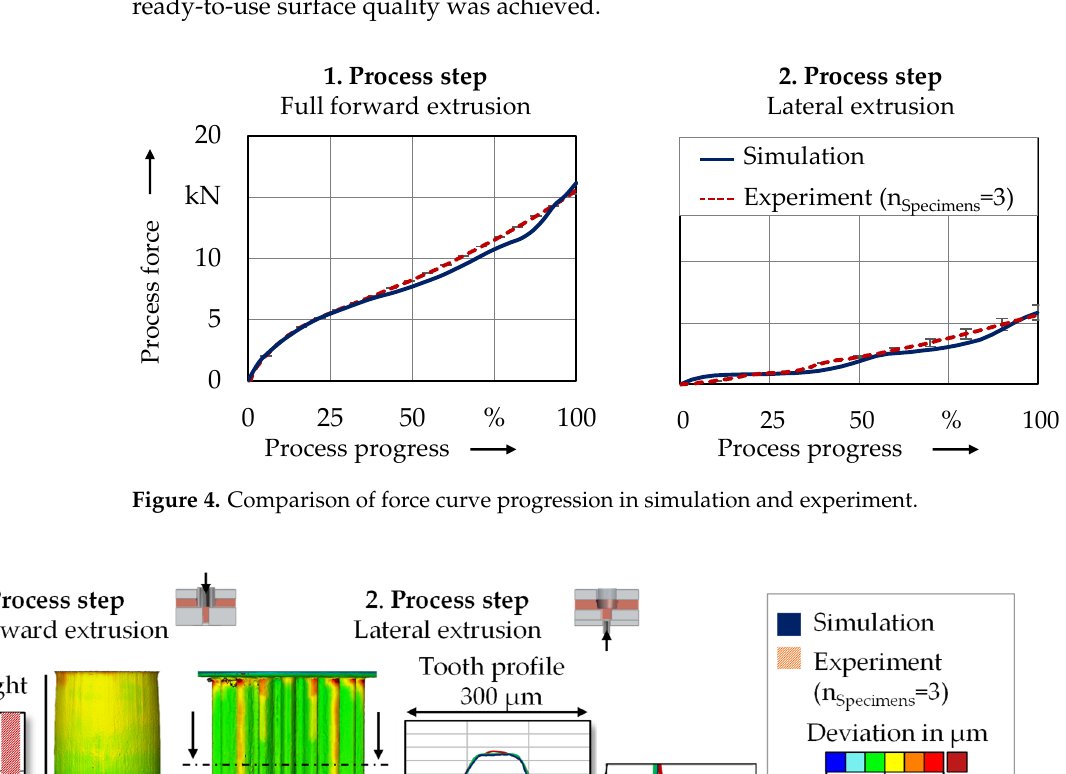
Figure 5. Comparison of component geometry in simulation and experiment. The pin heights differed slightly, being 3.8 mm in the simulation and 4.2 ± 0.1 mm in